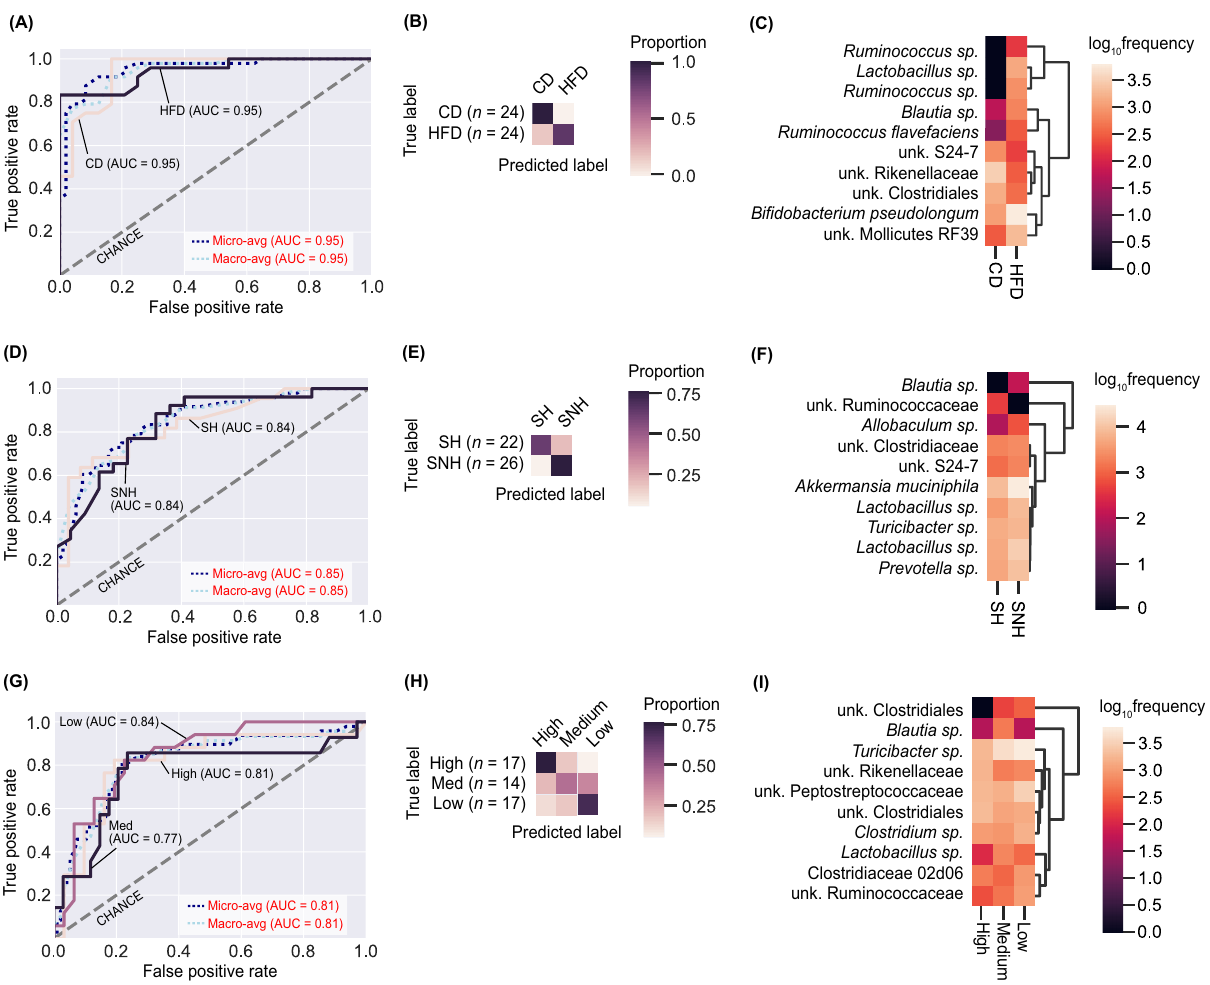
Figure 6. Machine learning reliably predicts ( A–C ) F 0 paternal dietary condition (control diet/CD or high-fat diet/HFD), ( D–F ) F 0 maternal housing condition (standard housing/SH or semi-naturalistic housing/SNH), and ( G–I ) maternal care levels (high, medium, or low) based on differential features in the F 1 offspring gut microbiome. Maternal care categories are based on a composite score of licking, grooming, and arched-back nursing scored during observational periods of 72 min, 5 times a day, for 7 consecutive days from postnatal days PD1–7. Feature inputs from the raw feature table included in this analysis consisted of all bacteria matched to the Greengenes 13/8 ribosomal ribonucleic acid (RNA) reference database with 99% accuracy. ( A,D,G ) Per-class receiver operating characteristic (ROC) plots demonstrate micro-average precision (averaged metrics across each sample, dark blue dashed line), macro-average precision (equal weights assigned to each classification level, light blue dashed line), and classification error rate achieved by random chance (grey dashed line) at several true-positive rate (TPR) against false-positive rate (FPR) thresholds. Predictive precision results for each classification level are shown in nude (( A ), control diet, CD; ( D ), standard housing, SH; ( G ), high maternal care, High), dark purple (( A ), high-fat diet, HFD; ( D ), semi-naturalistic housing, SNH; ( G ), moderate maternal care, Medium), and light purple (( G ), low maternal care, Low); overall classification accuracy was greater than 80% in each model. ( B,E,H ) Prediction matrices show which samples were correctly classified (true label and predicted labels match) and which samples were incorrectly classified (true label and predicted labels mismatch) by the model; darker hues correspond to more accurate assessments of the true group designation for all samples. ( C,F,I ) Feature heatmaps show microbial features that were used to classify samples in each category after all parameters were tuned and optimized for the greatest predictive accuracy. Heatmap colors indicate log 10 frequency of each feature in the dataset. AUC area-under-the-curve, CD control diet, FPR false-positive rate, HFD high-fat diet, PD postnatal day, ROC receiver operating characteristics, TPR true-positive